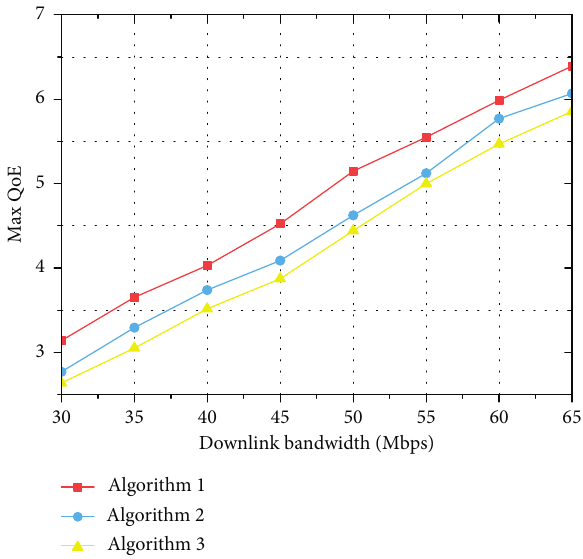
Figure 10: Relationship between downlink bandwidth and system QoE